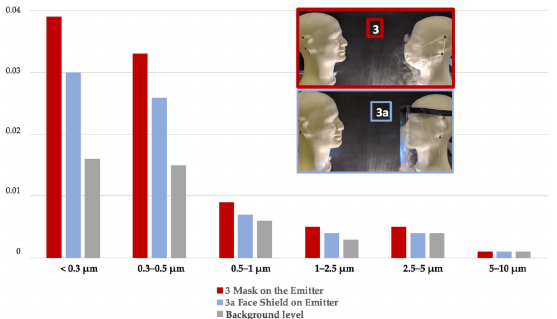
Figure 7. Percentage of Total Inhaled Particles (PTIP) with protection only for Emitter (Em): mask vs. face shield for each particle size range compared to lack of protection.